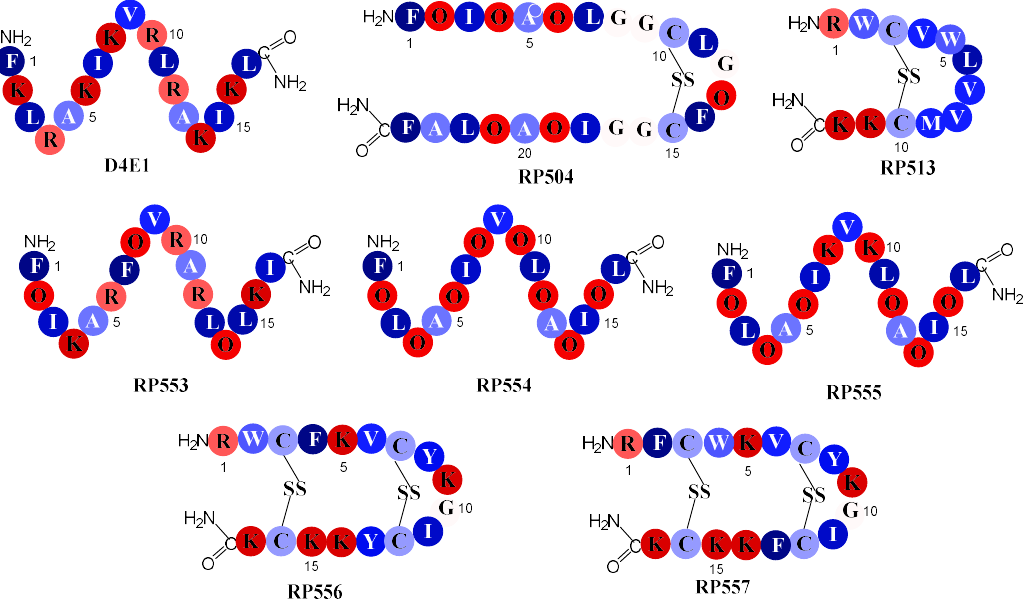
Figure 1. Schematic relative hydrophobicity representation of the designed antimicrobial peptides. Single letter codes of the amino acids are depicted with dark blue representing the most hydrophobic amino acid, phenylalanine (F), through to the hydrophilic amino acids in red, lysine (K). Relative hydrophobicity represented by the energy, kcal / mole, necessary to move an amino acid from an aqueous phase to a lipid bilayer [22]: F, phenylalanine, − 3.85; L, leucine, − 3.36; I, isoleucine, − 3.16; Y,